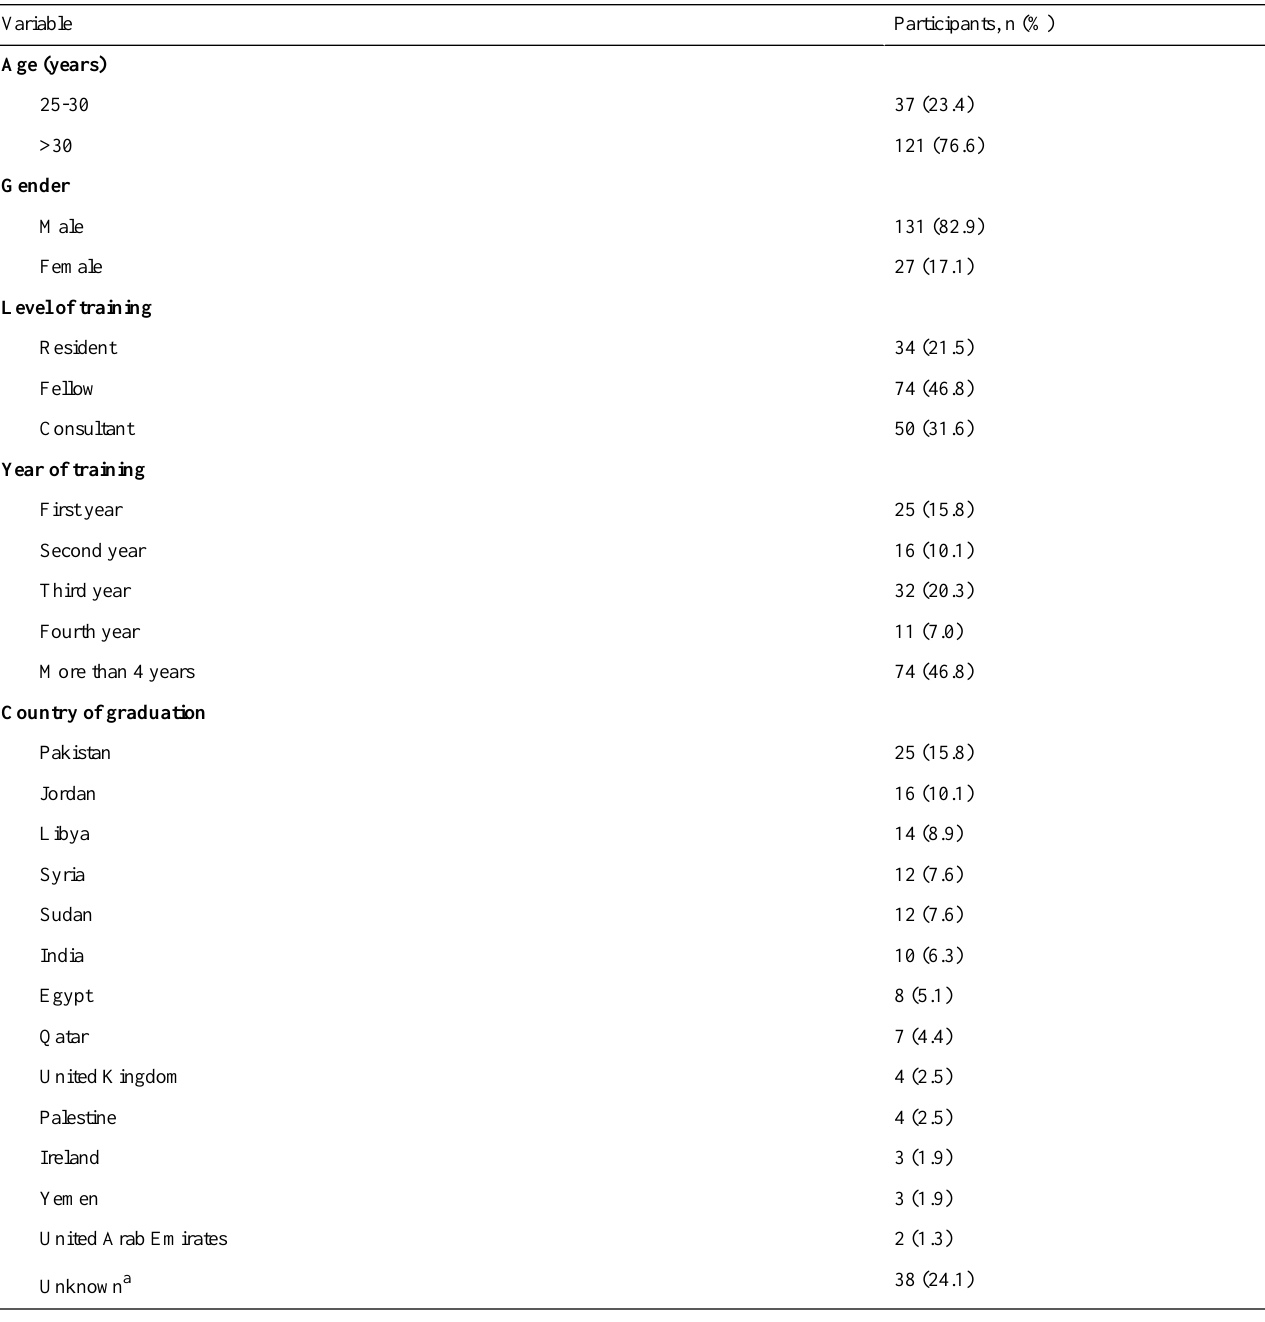
Table 1. Demographics of the survey participants